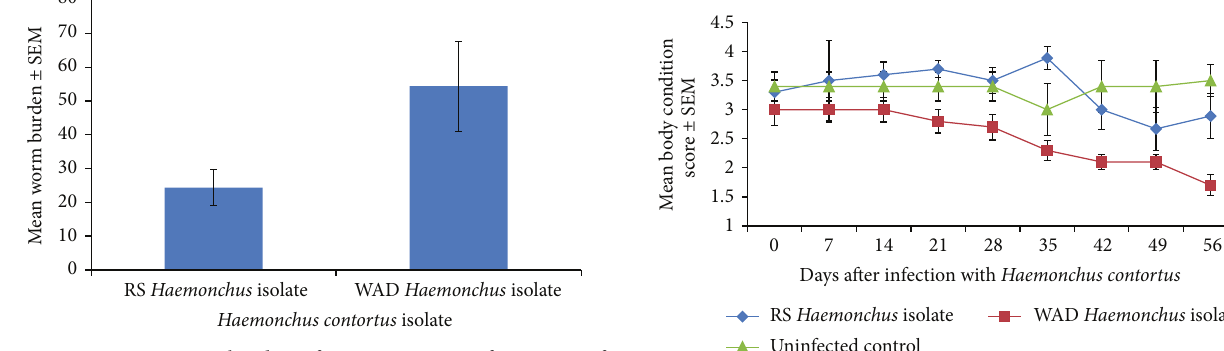
Figure 2: Mean worm burden of Nigerian West African Dwarf (WAD) goats given a single pulse infection with either a Red Sokoto (RS) or a WAD goat isolate of H. contortus .